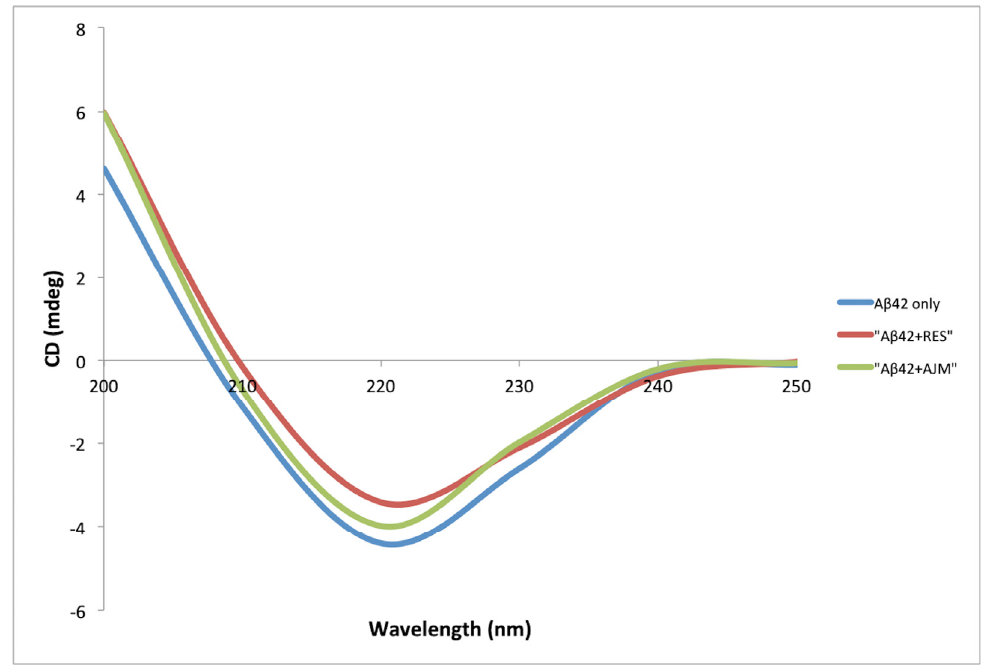
Figure 7. Circular dichroism (CD) spectra of A β 42 (22 μ M) alone (blue), A β 42 with RES (22 μ M) (red), and A β 42 with AJM (22 μ M) (green).